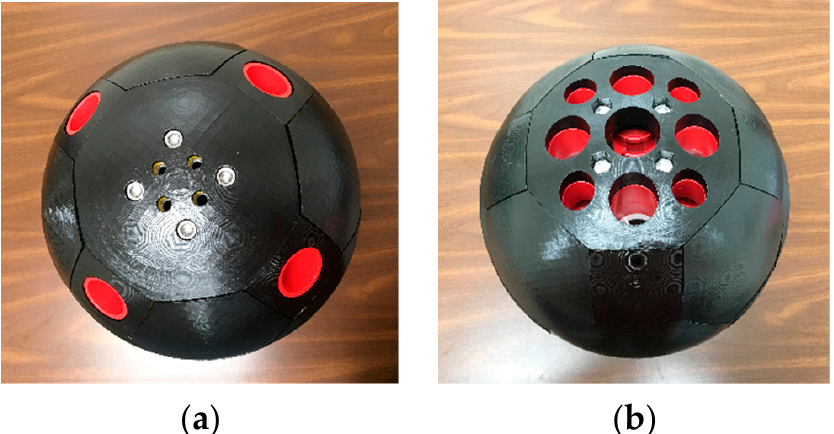
Figure 10. Top and bottom hull plates ( a ) Top plate, displaying the four circular retention bolt heads, with the carry handle removed ( b ) Bottom plate, displaying the hexagonal bolt heads, thruster inlets and (empty) ballast and central payload tube ports.